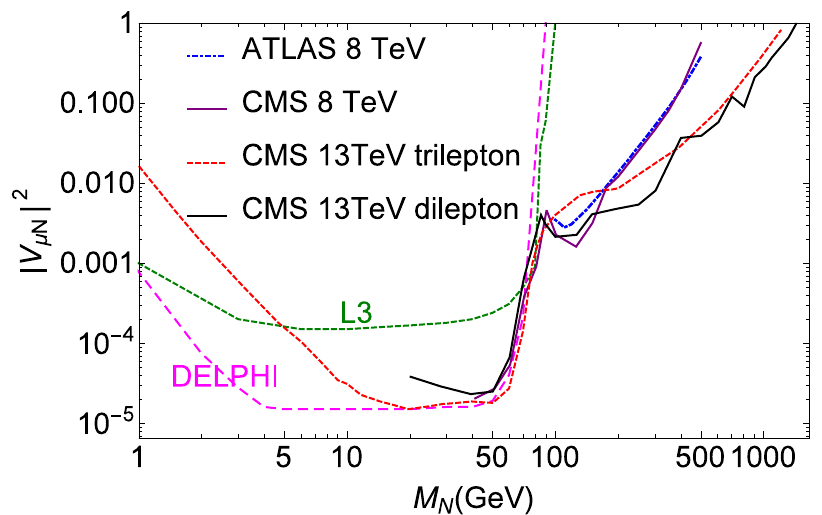
Figure 1 . Limits at 95% CL on the mixing between the muon neutrino (cid:23) (cid:22) and a single heavy neutrino in the mass range 1 GeV - 1600 GeV, from di(cid:11)erent current collider direct searches: L3 [75], DELPHI [76], ATLAS [42], CMS 8 TeV data [44], and the the trilepton analysis [46] and dilepton analysis [47] based on CMS 13 TeV